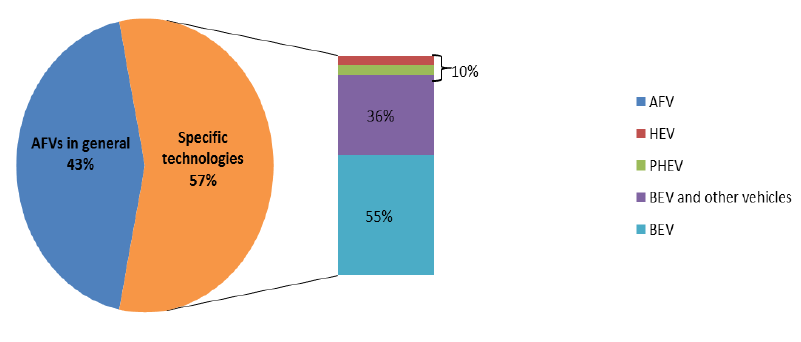
Figure 4. CM studies by scope.